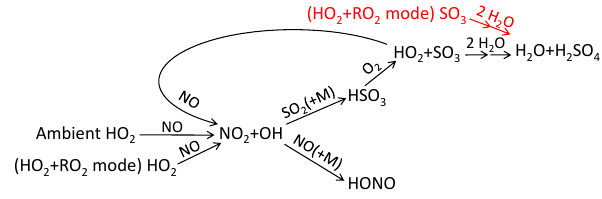
Scheme 2. PeRCIMS inlet HO 2 chemistry. Reactions in black